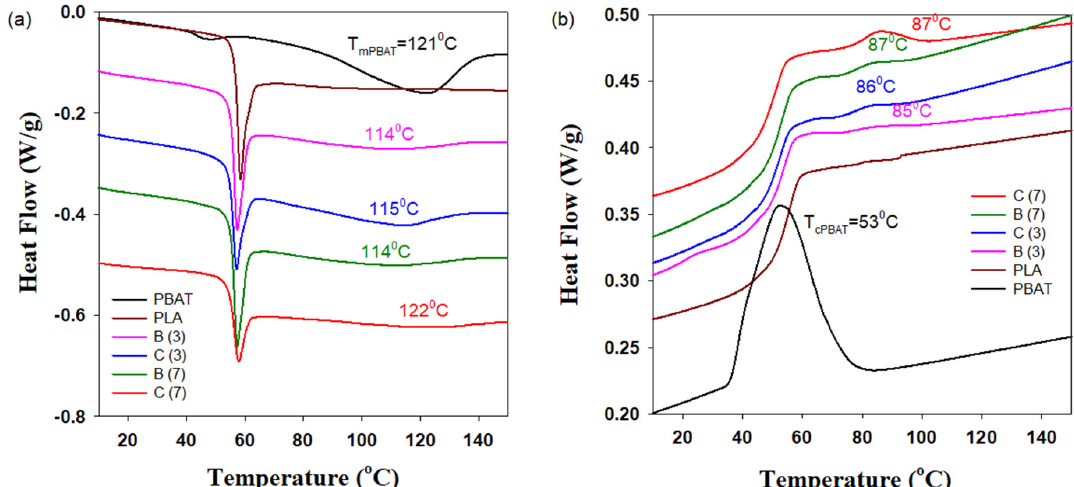
Figure 4. Heating endotherms ( a ) and cooling exotherms ( b ) of PLA and PBAT as well as PLA/PBAT/CNFs blends and in situ generated composites. C and B stand for the composite and blend, respectively. The numbers in parentheses indicate the concentration of CNFs.